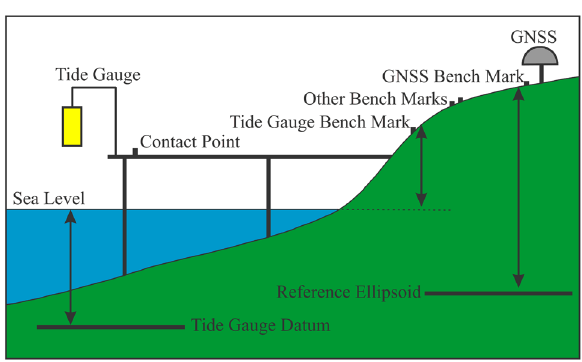
Figure 3. The structure of Japan tide observation station at GSI along the coastal area to continuously monitor the sea